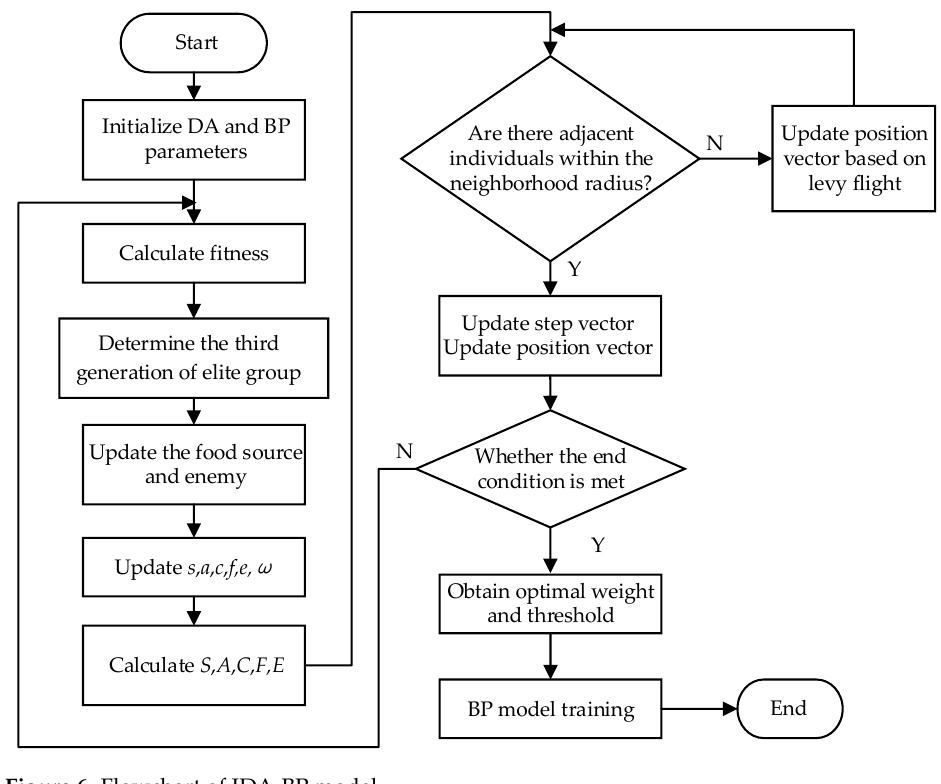
Figure 6. Flowchart of IDA-BP model.